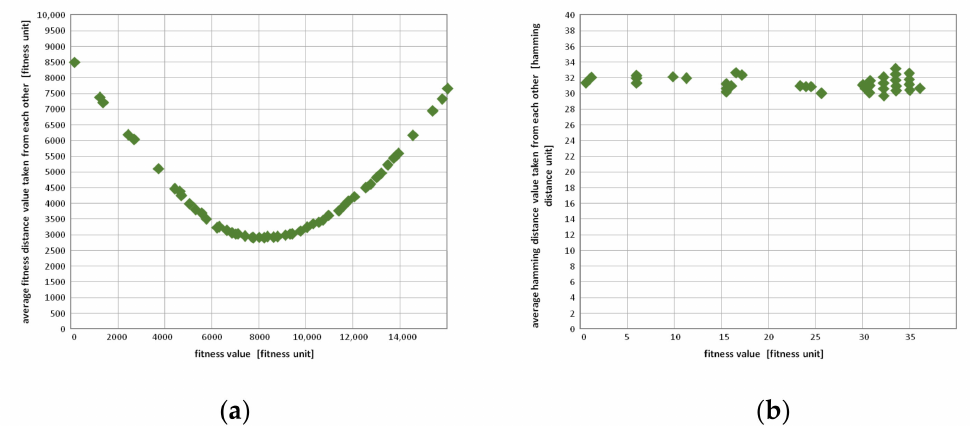
Figure 12. The distance from the best solution and the average of the fitness distances ( a ) and the hamming distances ( b ) from the other solutions in case of 2-opt operator.